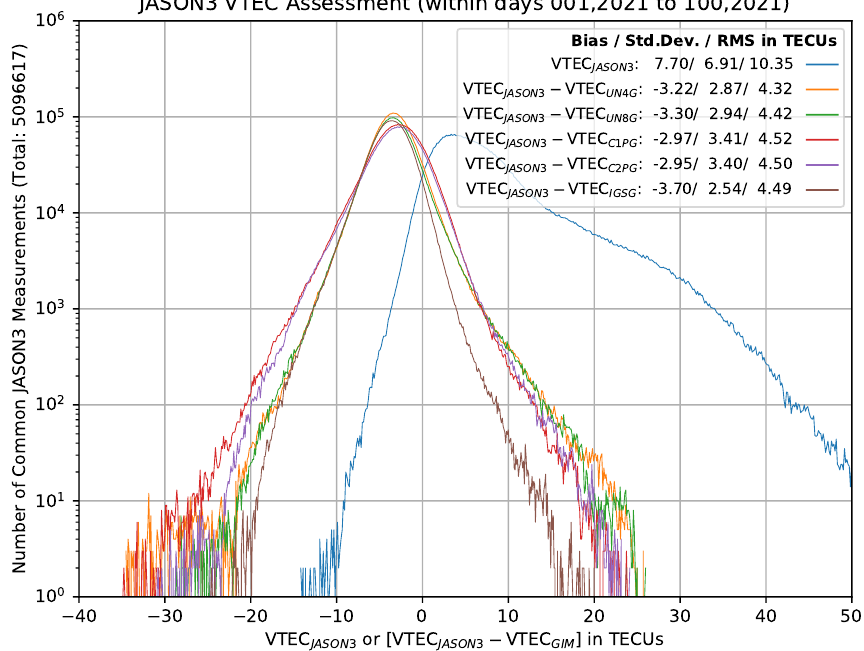
Figure 13. Histogram, in log scale for the number of counts, of VTEC difference of JASON3 measure- ment minus GIMs value for the first 100 days of 2021, the color code indicates the comparison for different forecasting products. The histogram of the reference values of JASON3 is represented in gray. The corresponding overall bias, standard deviation (Std.Dev.), and RMS are indicated in the upper right